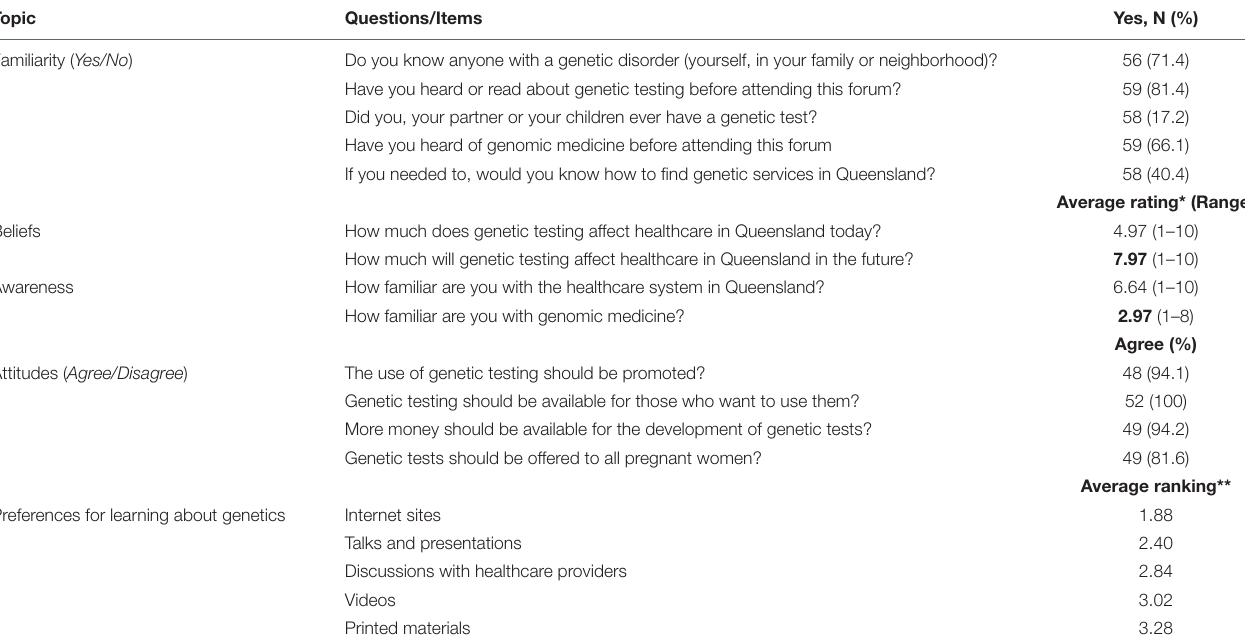
TABLE 1 | Summary of consumer survey responses from 59 participants evaluating genomic familiarity, awareness, and beliefs, preferences for learning modalities, and attitudes toward genetic